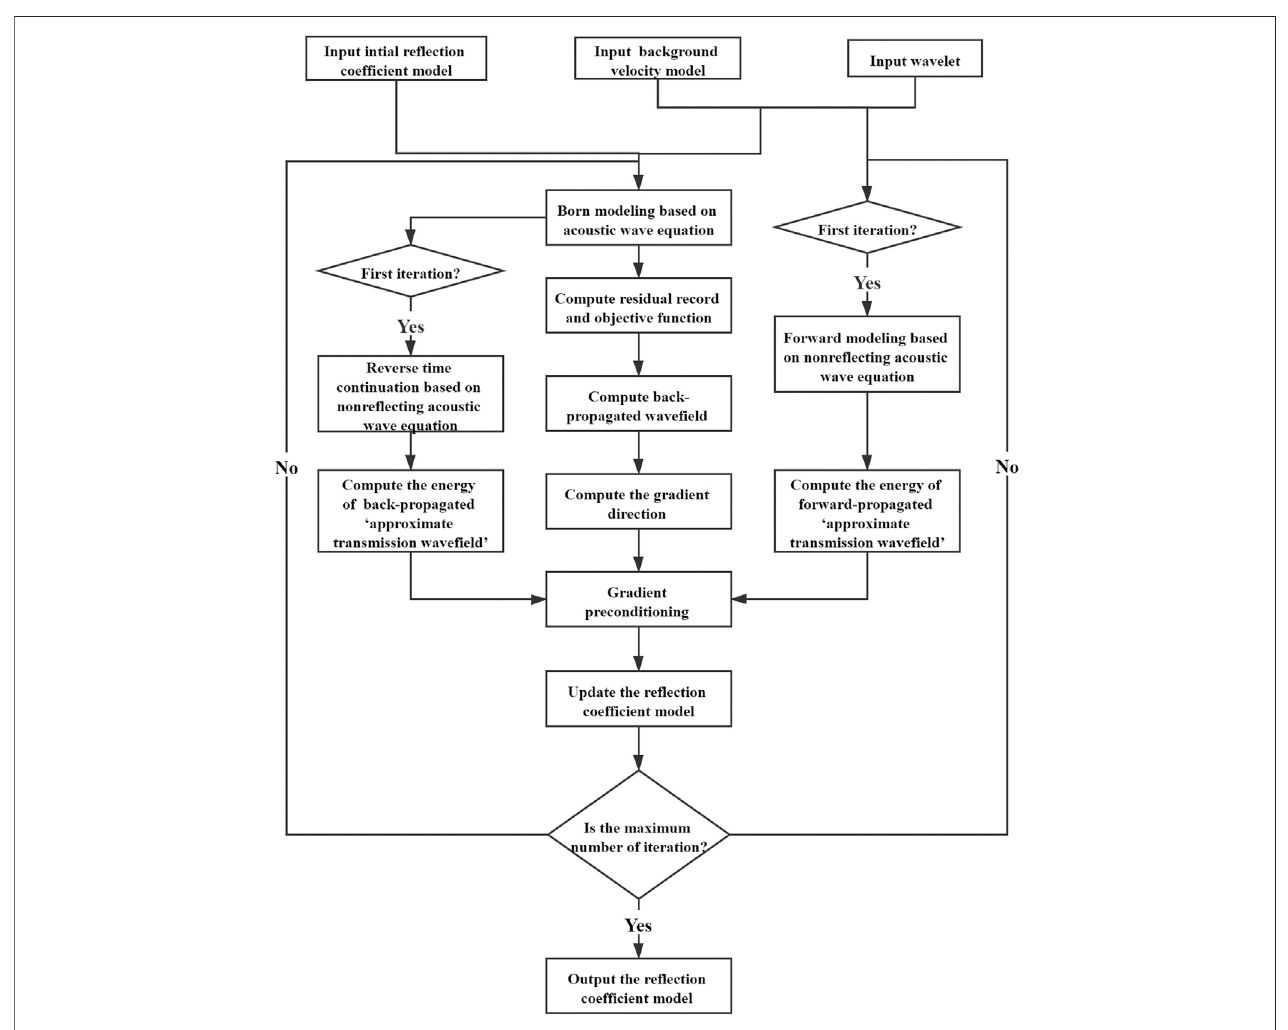
FIGURE 1 | Flowchart of the LSRTM using